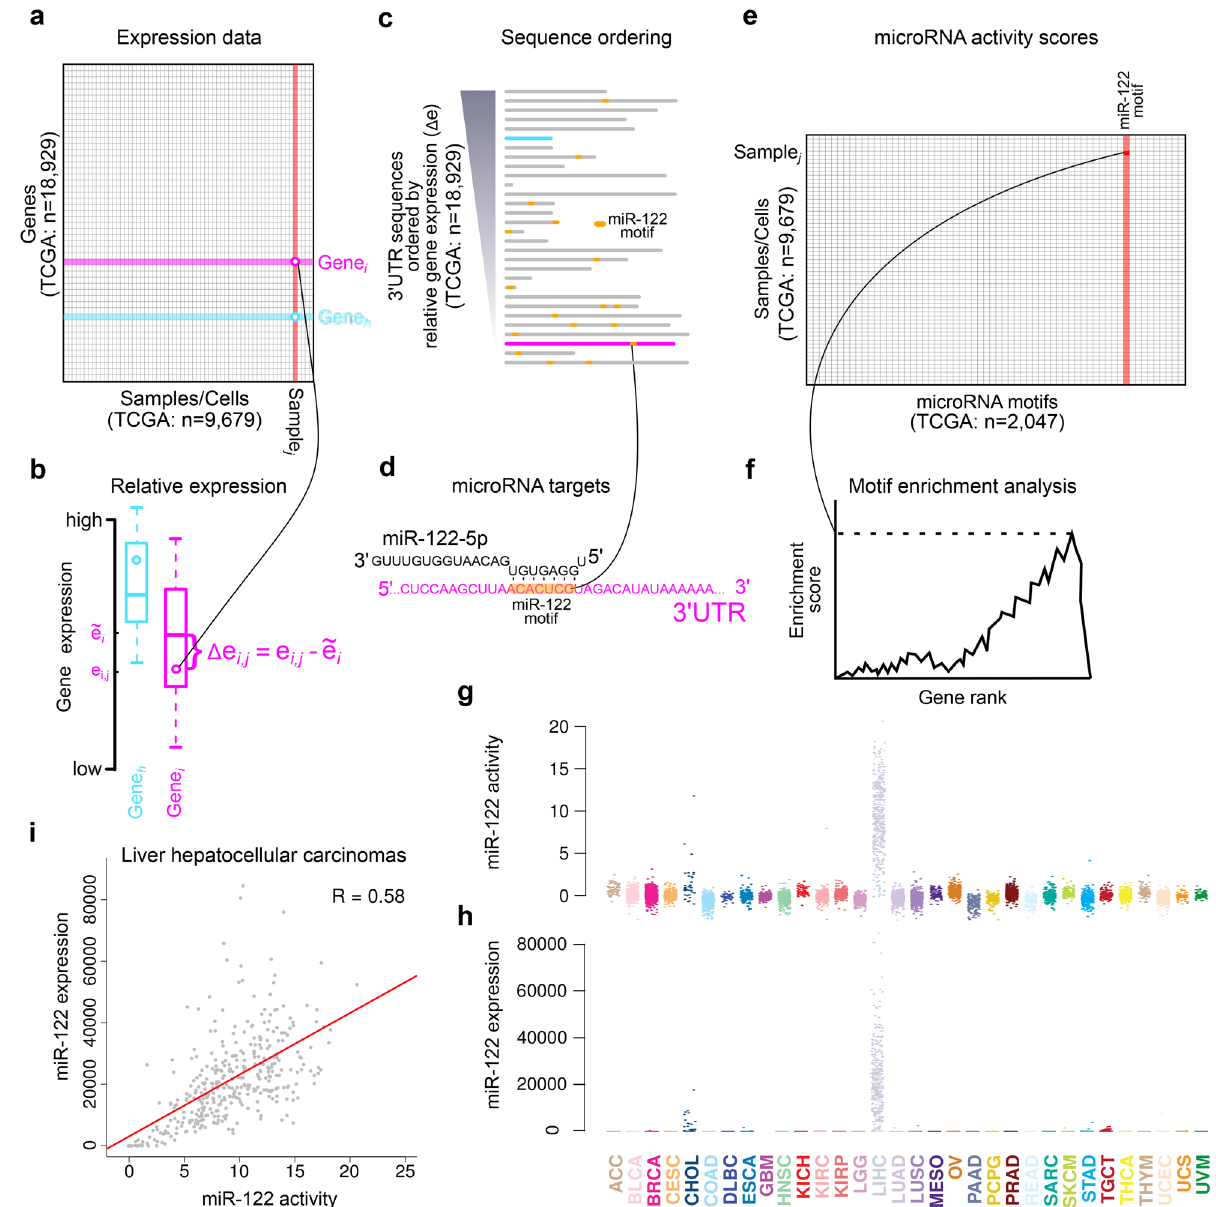
Figure 1. Method overview and illustration on miR-122 and TCGA data. Gene level expression data ( a ) is converted into sample/cell relative expression (∆e) ( b ) by subtraction of gene medians (denoted by ~) obtained across all samples/cells. For each sample/cell, 3 ′ UTR sequences sorted by relative gene expression ( c ) are annotated with miRNA motif presence ( d ) and subjected to motif enrichment analysis evaluating motifs’ association with expression ( f ). miRNA activity scores ( e ) are derived from the motif enrichment statistics to produce scores for each individual sample/cell for all miRNA binding motifs. g,h Activity scores for miR- 122-5p ( g ) and miR-122 expression ( h ) in TCGA samples. TCGA abbreviations are in Supplemental Table 1. i , Correlations between miR-122–5 activity scores and miR-122 expression across liver hepatocellular carcinomas